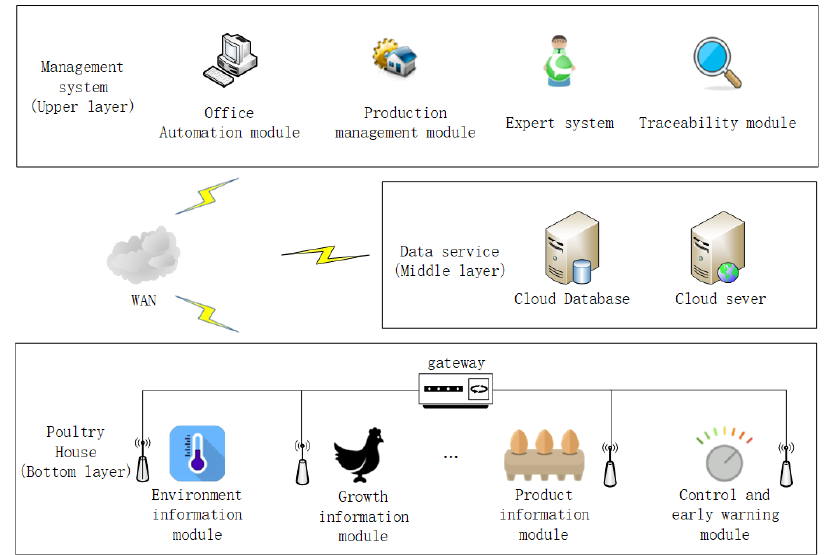
Figure 1. Overall structure of the system.